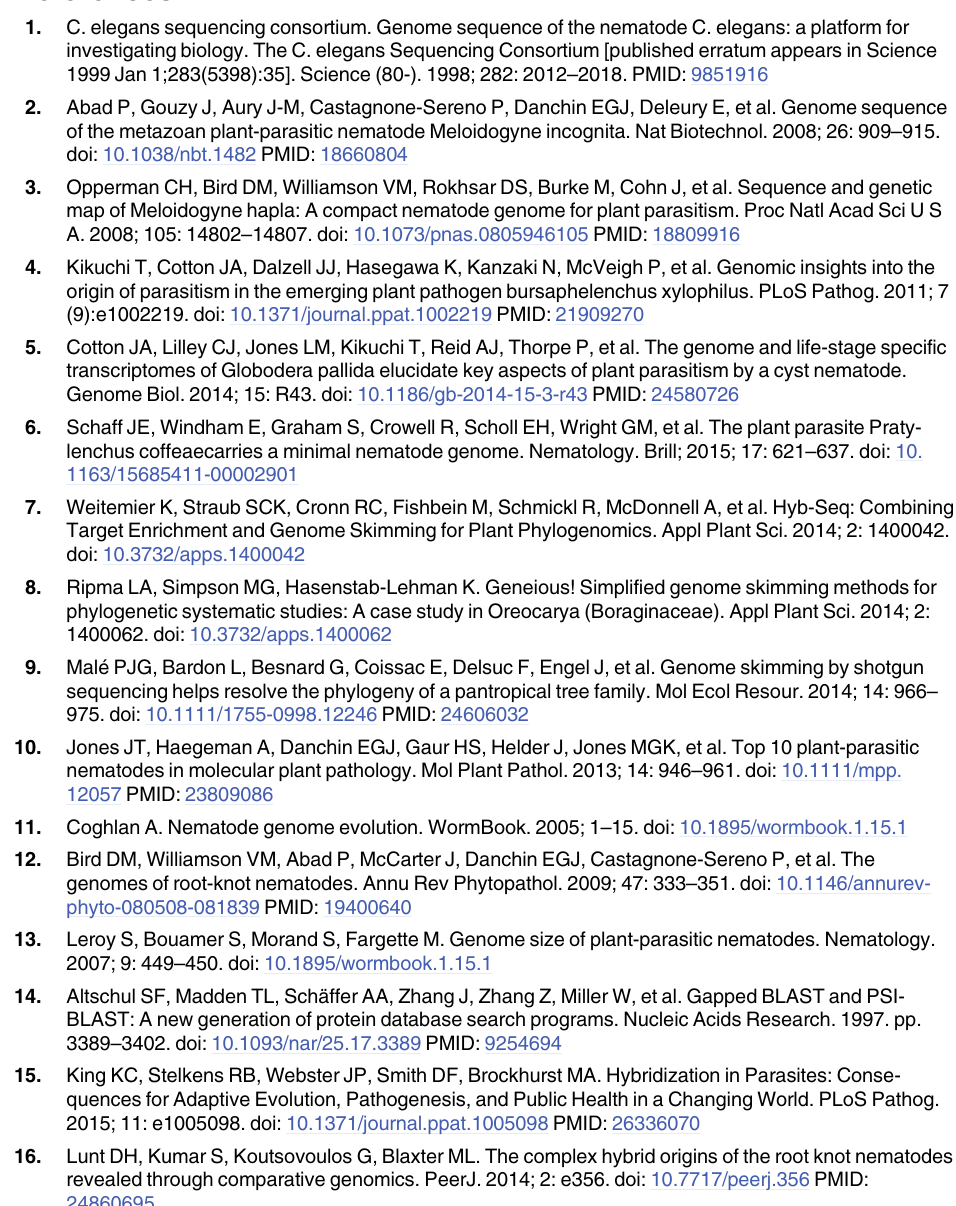
S2 Table. Effector Protein Sequences Used in BLAST